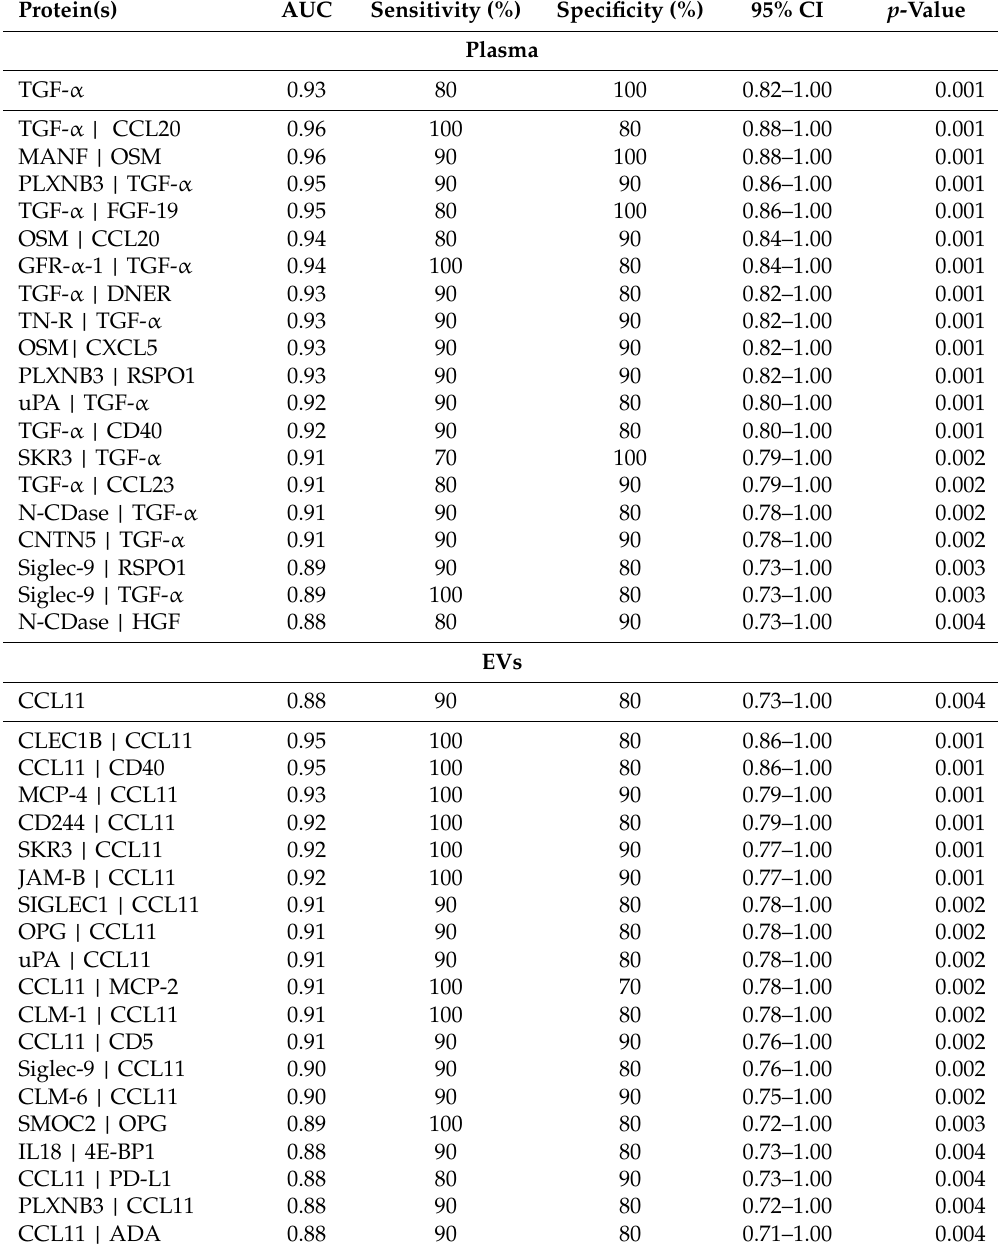
Table 4. Receiver operating characteristic curves for protein ratios and single proteins for plasma and extracellular vesicles comparing healthy controls with AD